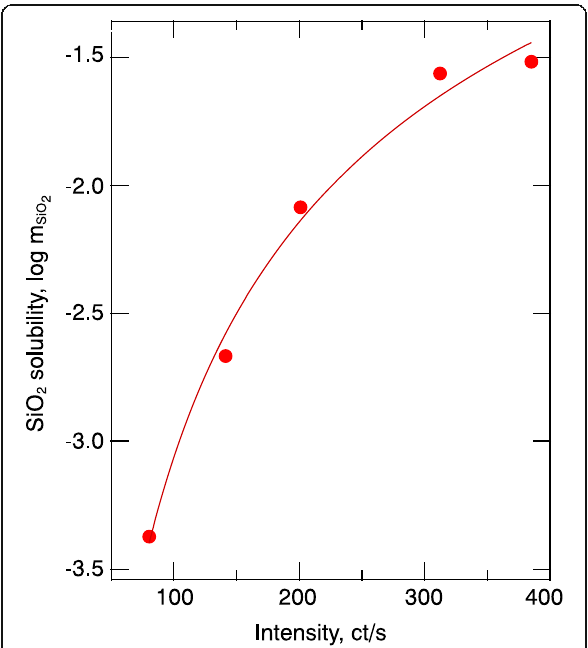
Fig. 5 Calibration curve for SiO 2 solubility as a function of 770+ 850 cm − 1 integrated band intensity from the system – H 2 O with silica solubility calculated with the algorithm of Manning (1994). The fitted curve is log m SiO2 (kg/mol)=1.6 – 2.0×Int − 0.32 , where “ Int ” denotes the integrated Raman intensity and m SiO2 is silica molality of aqueous fluid